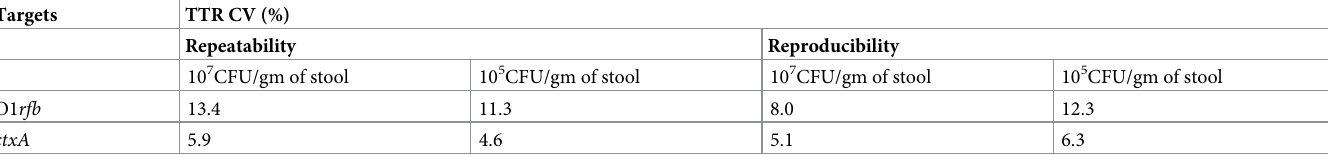
Table 3. Variations in cholera RLDT Time to Result (TTR) in repeatability and reproducibility analysis. Targets